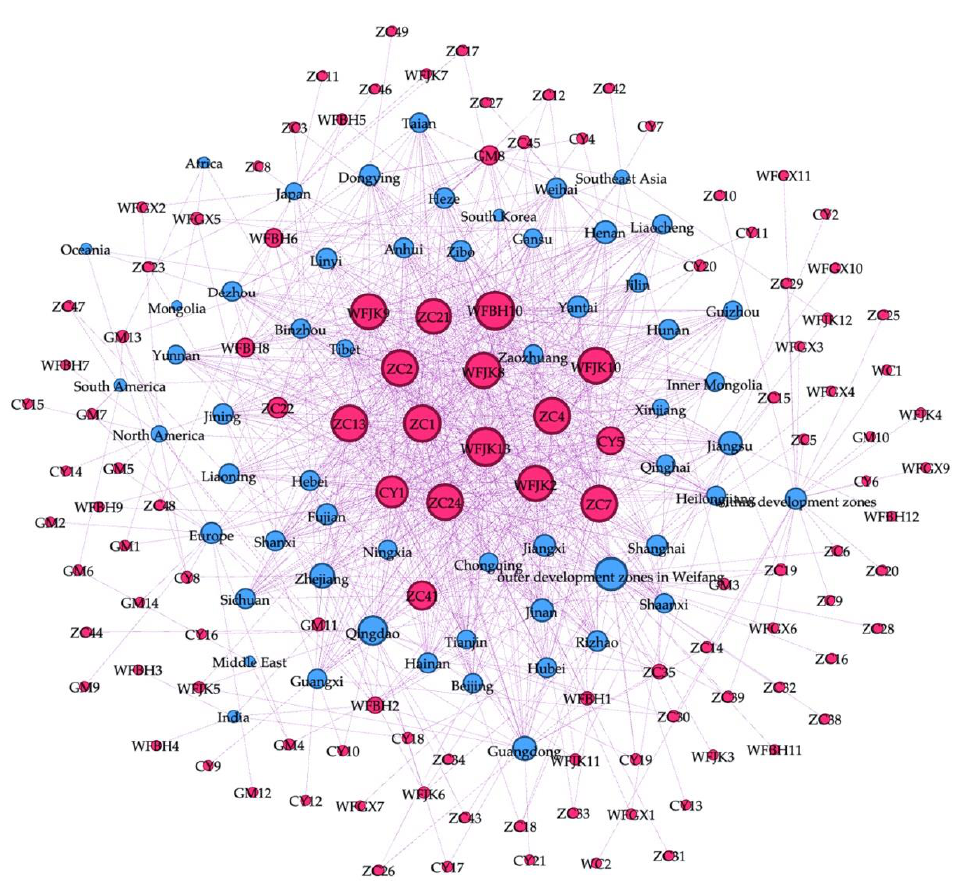
Figure 5. Firms’ sales logistics networks in Weifang ’s development zones before the outbreak of the pandemic. Note: The blue and red dots represent the sales destinations and the enterprises in the development zones, respectively; the lines represent the connection between the sales destinations and the enterprises in the development zones. A larger dot indicates that the node has a higher degree centrality in the network.